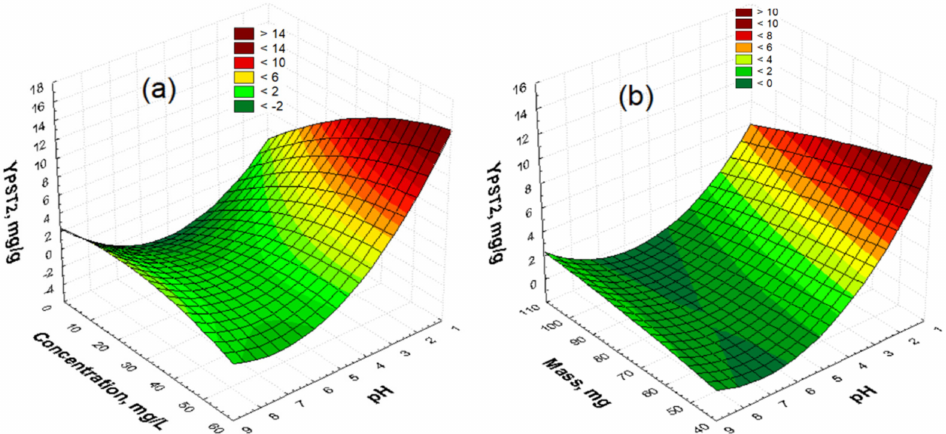
Figure 7. Surface response for the amount of IC adsorbed by the urea-treated (treatment 2) pistachio pod biomass PST2 as a function of concentration and pH effects ( a ), pH and mass effects ( b